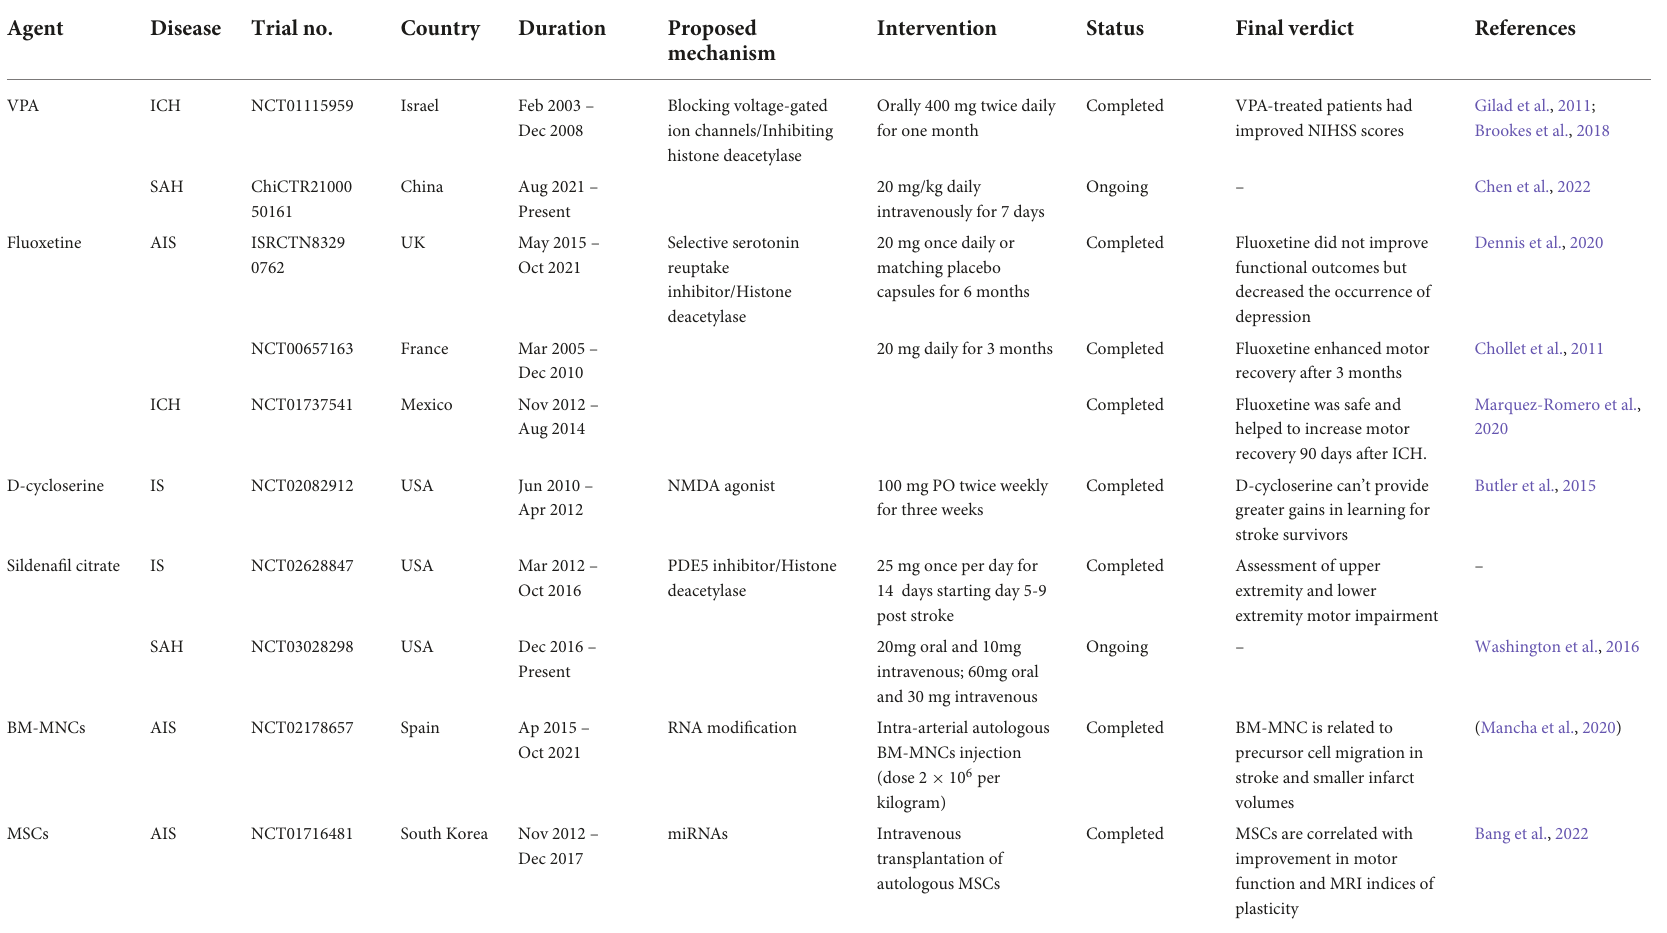
TABLE 2 Clinical trials with epigenetic-related agents in stroke